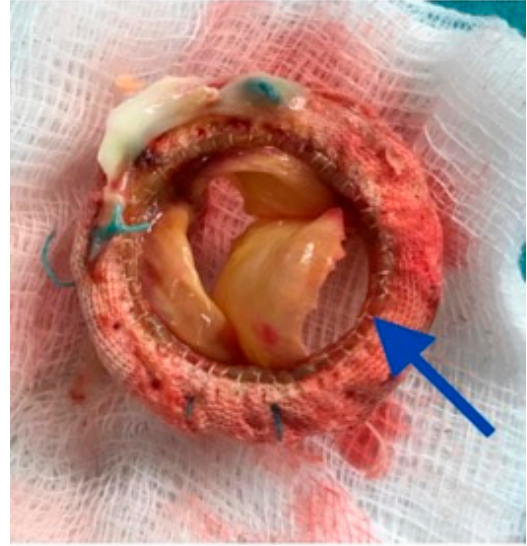
Figure 4. Explanted mitral valve bioprosthesis basal cusp tear (blue arrow) almost from commissure to commissure.